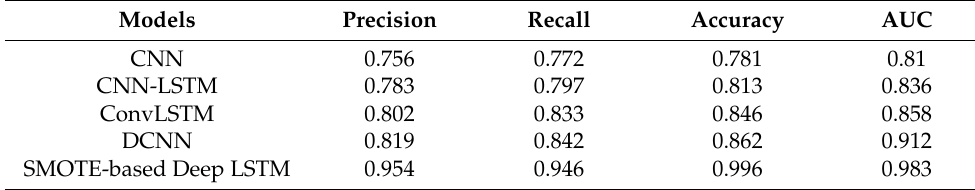
Table 5. Comparison of different deep-learning models.